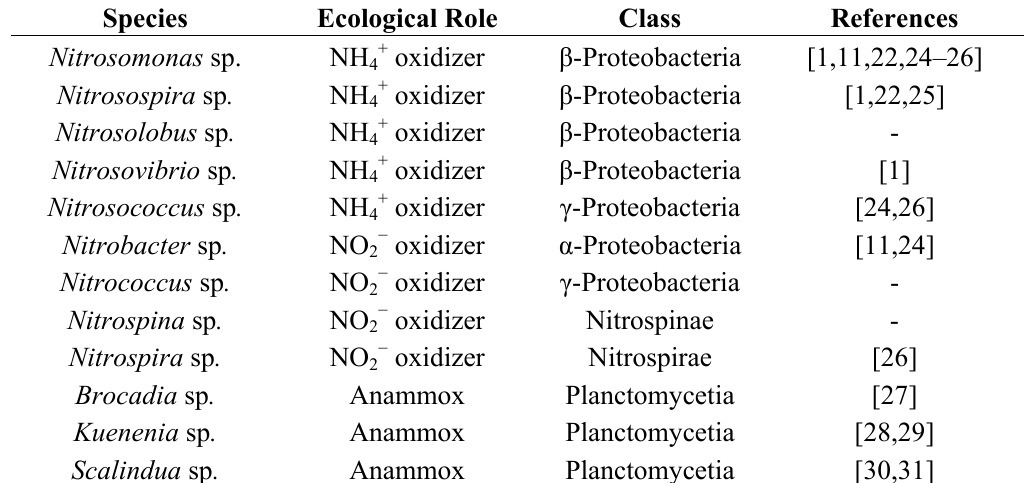
Table 2. References for the identification of ammonium-oxidizing bacteria (AOB), nitrite-oxidizing bacteria (NOB) and anammox bacteria in engineered and natural